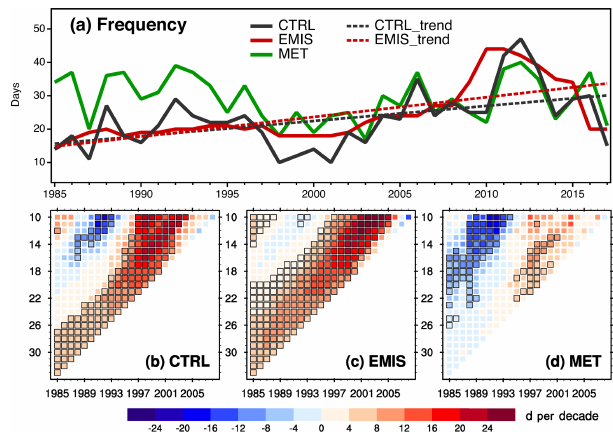
Figure 10. (a) Time series of frequencies (days) of regional SWHD in BTH from three simulations (CTRL, EMIS, MET) for 1985 to 2017. (b–e) Time series of linear trends calculated over different periods for simulated frequencies of the (b) CTRL, (c) EMIS, and (d) MET simulations. The x axis indicates the start year, and the y axis indicates the number of years since the start year during which period the trend is calculated. The filled color in each square shows the calculated trend value, and those values marked with black borders are significant above the 95% confidence